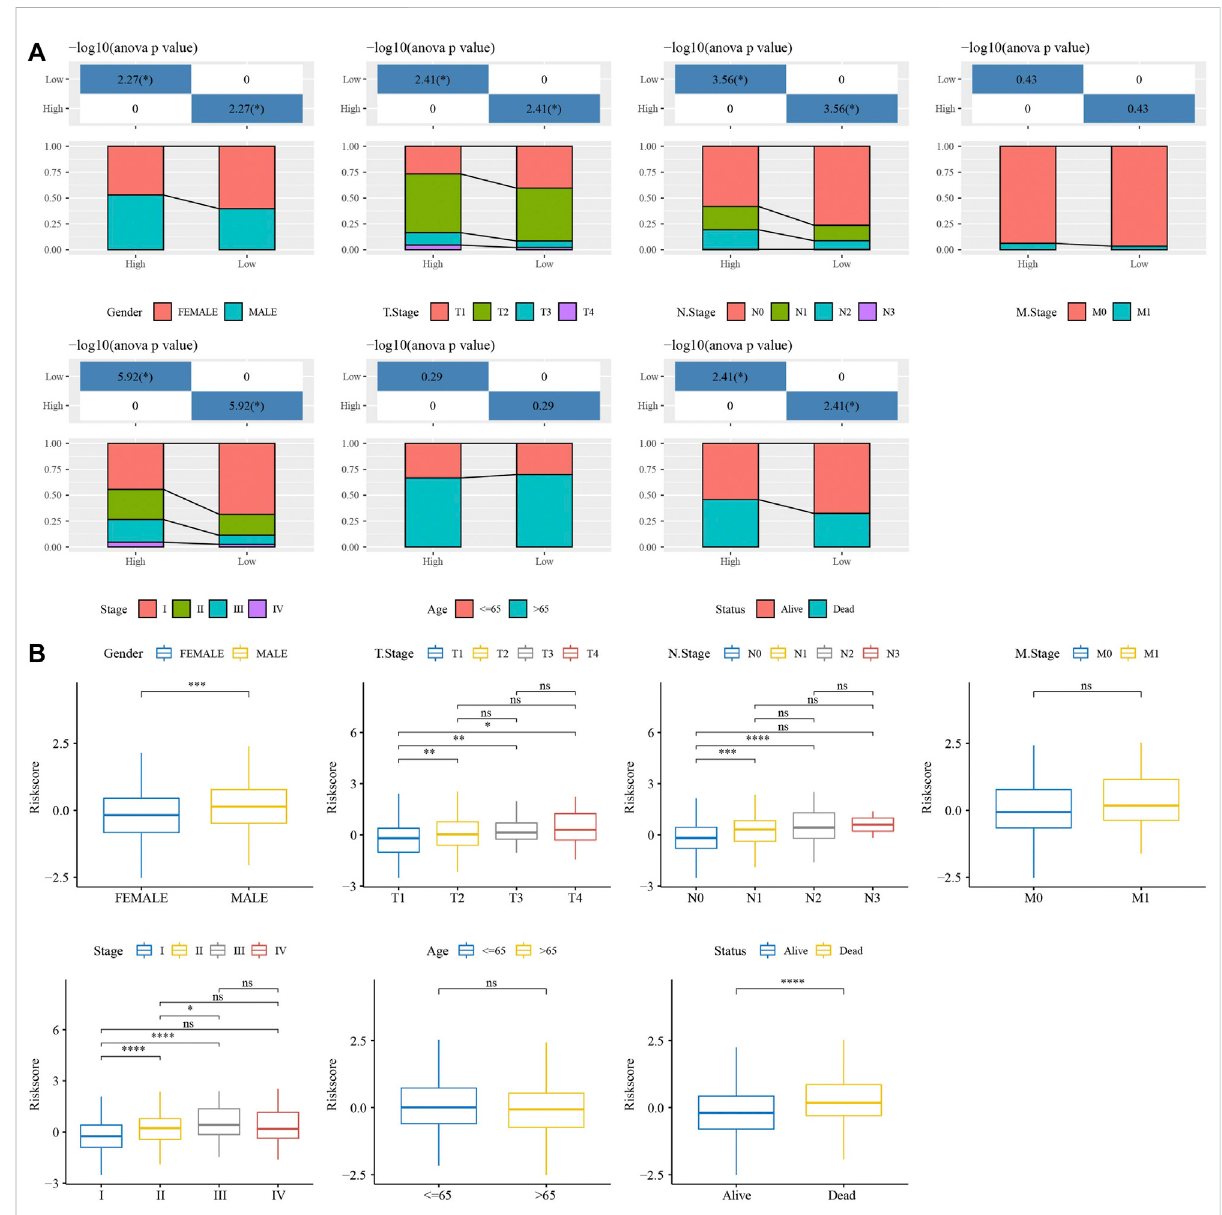
FIGURE 9 Analysis of clinical features in RiskScore. (A) The distribution of clinical features groups, included Gender, T Stage, N Stage, M Stage, Stage, Age andStatus,inhighgroupandlowgroup. (B) TheRiskScoredifferencesanalysisinclinicalfeaturesgroups,includedGender,TStage,NStage,MStage, Stage, Age and Status. * p < 0.05, ** p < 0.01, *** p < 0.001, *** p < 0.0001, ns: no signi fi